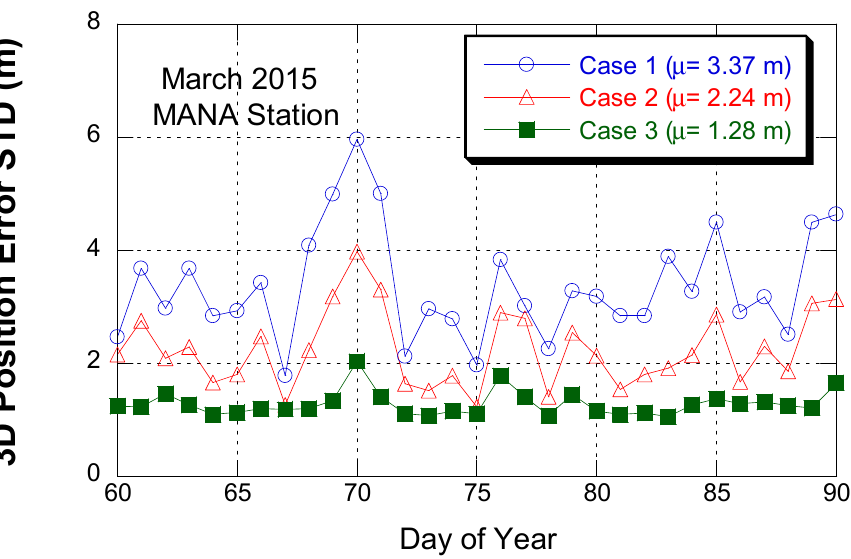
Figure 9. Positioning error STD variation at MANA station in March 2015.